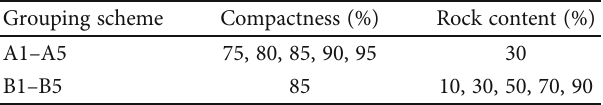
Table 2: Design of experimental scheme. Grouping scheme Compactness